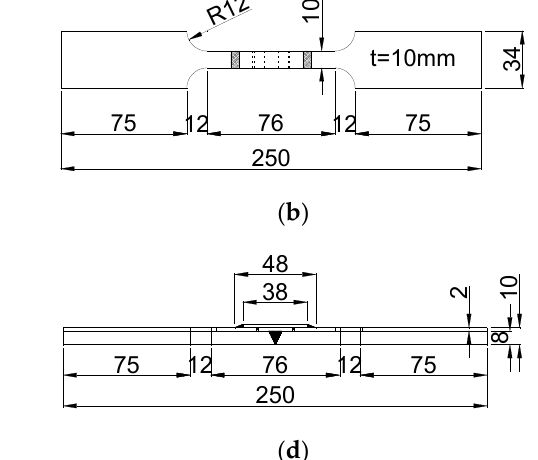
Figure 6. Geometric dimensions of test coupons for TC bimetallic steel welded joints. ( a ) Type II: plan size, ( b ) Type III: plan size, ( c ) Type II: side view and ( d ) Type III: side view.